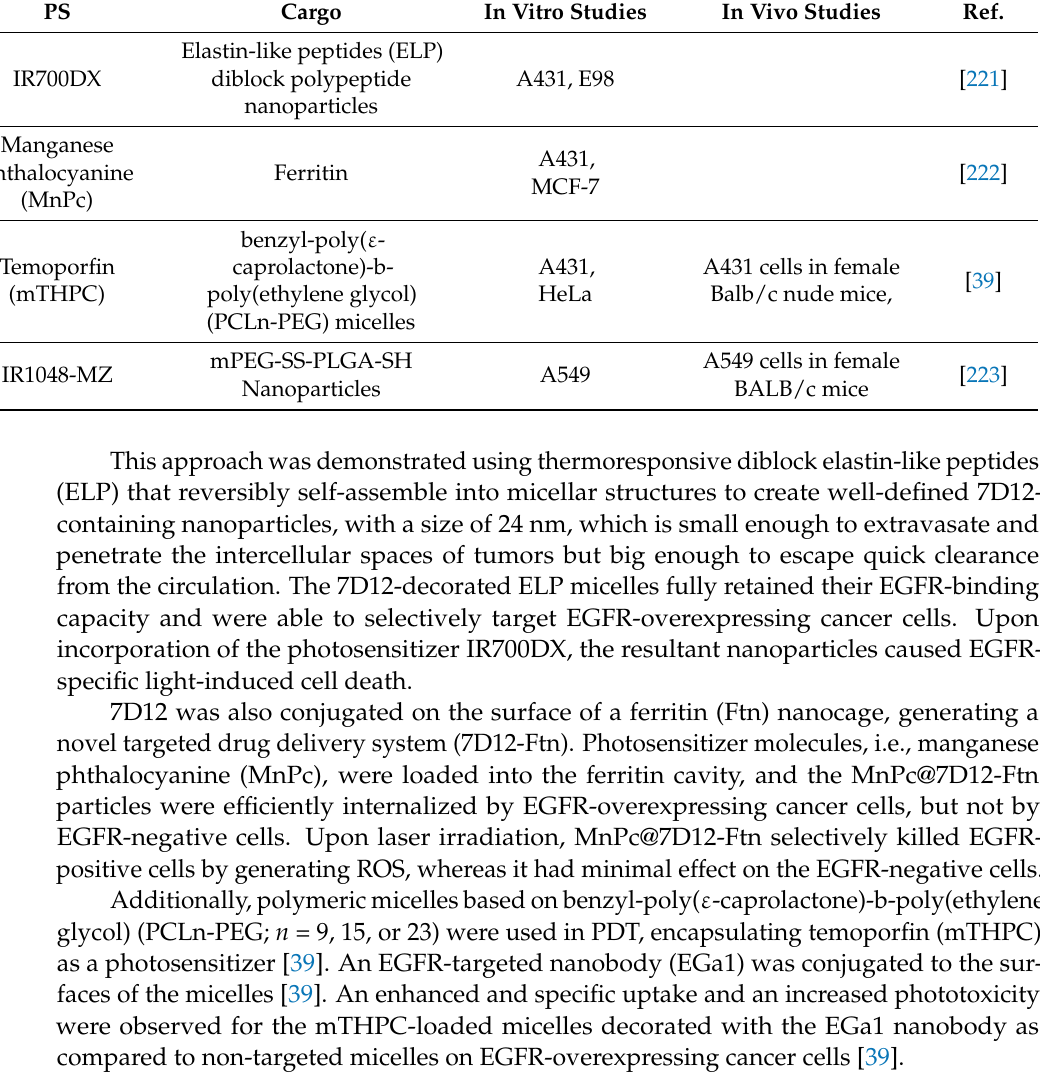
Cargo In Vitro Studies In Vivo Studies